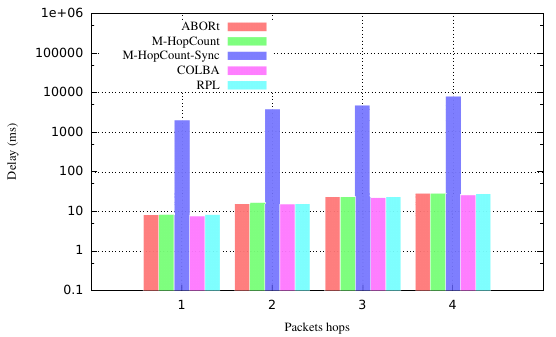
Figure 9. End-to-end delay per hop for 5 pkts/s/node.